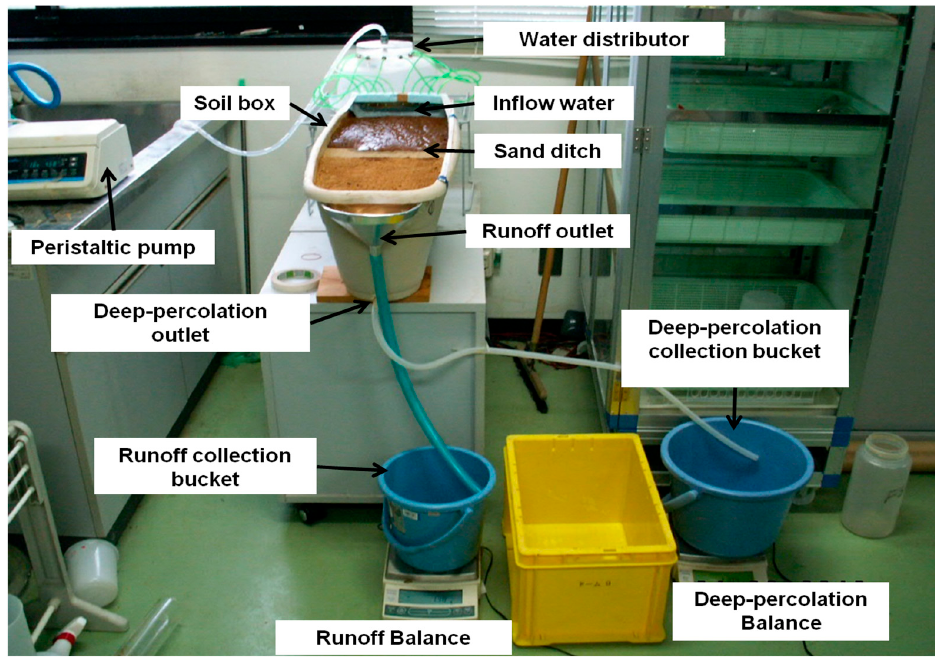
Figure 1. Picture for the experimental setup.